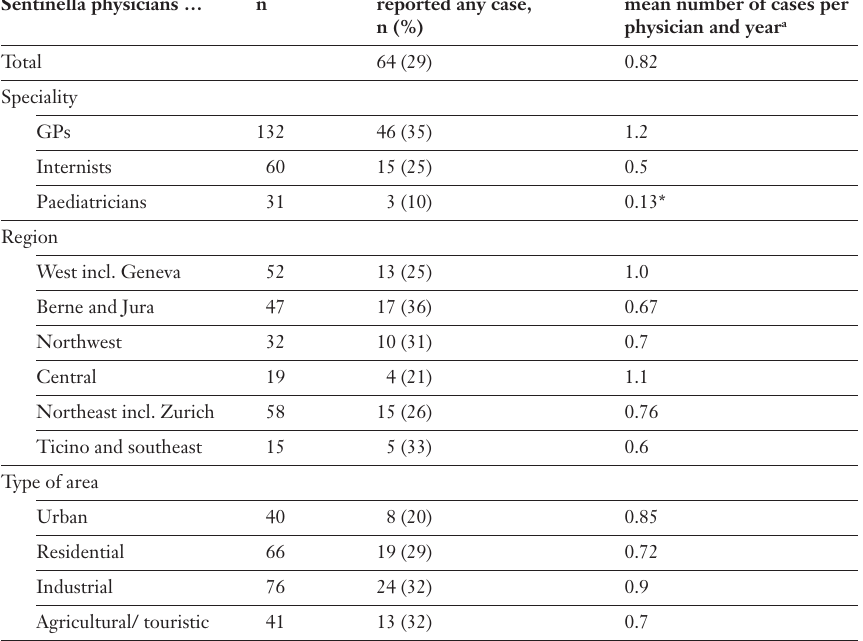
Table 1 Number of physi- cians reporting any case and mean num- ber of cases per physician and year, by specialty, region and type of